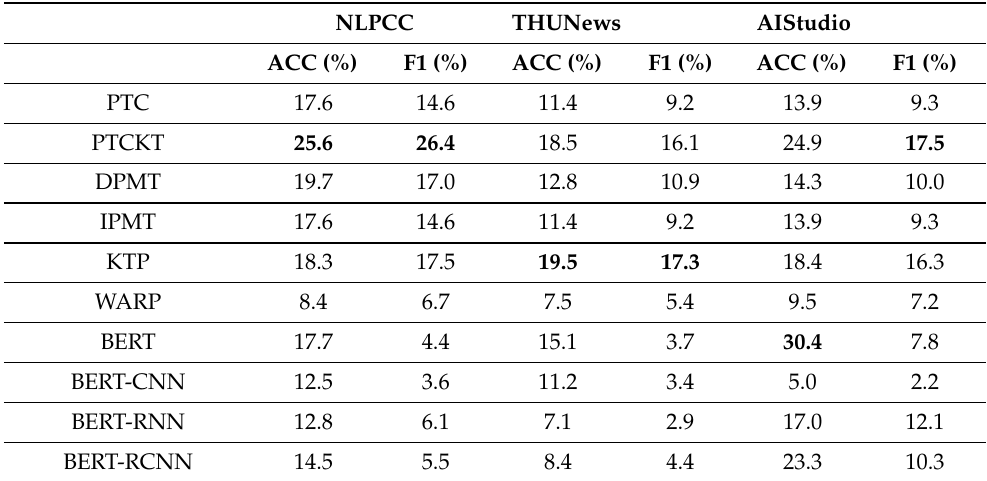
Table 3. Accuracy and F1 scores for all the methods in the zero-shot setting on different datasets. Bold stands for the